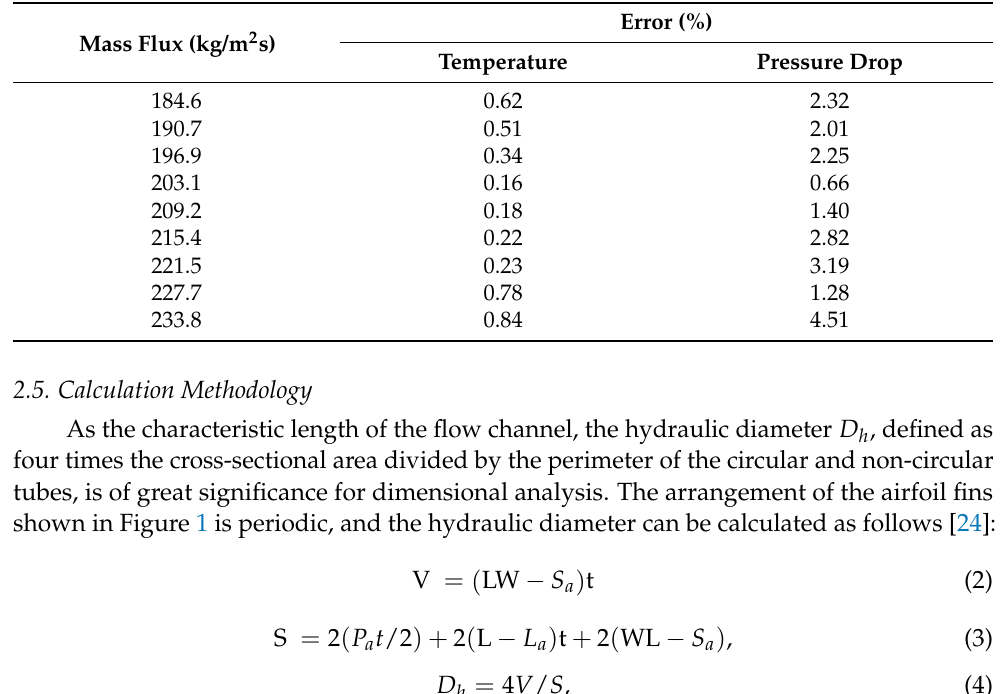
Table 3. Comparison between numerical and experimental data.